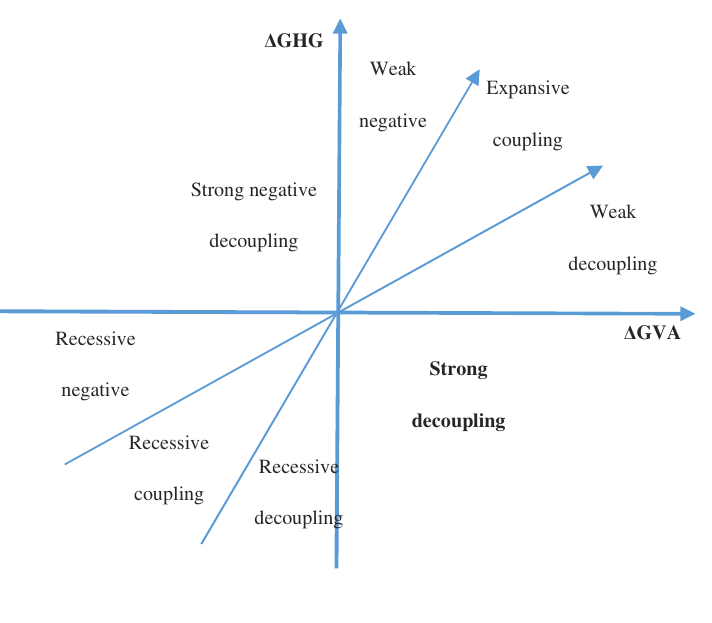
Figure 1. Relative and absolute decoupling of economic growth and environmental impacts (modified from UNEP, 2011)